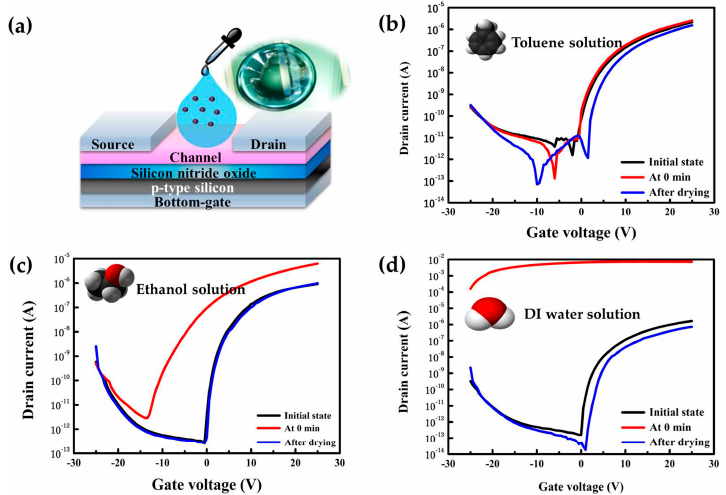
Figure 3 Figure 3. Transfer characteristics I DS -V GS of solution-processed ZnO-based TFT sensors for